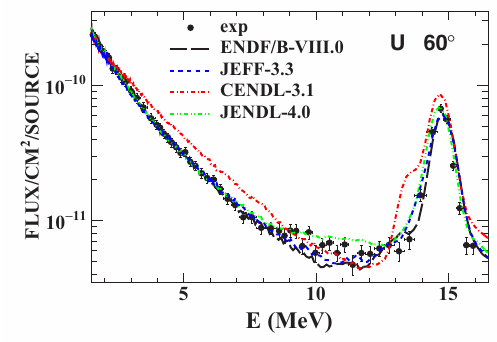
Figure 8. Neutron leakage spectra for W sample at 60 ◦ . Figure 3. Neutron leakage spectra for Ga sample at 120 ◦ .